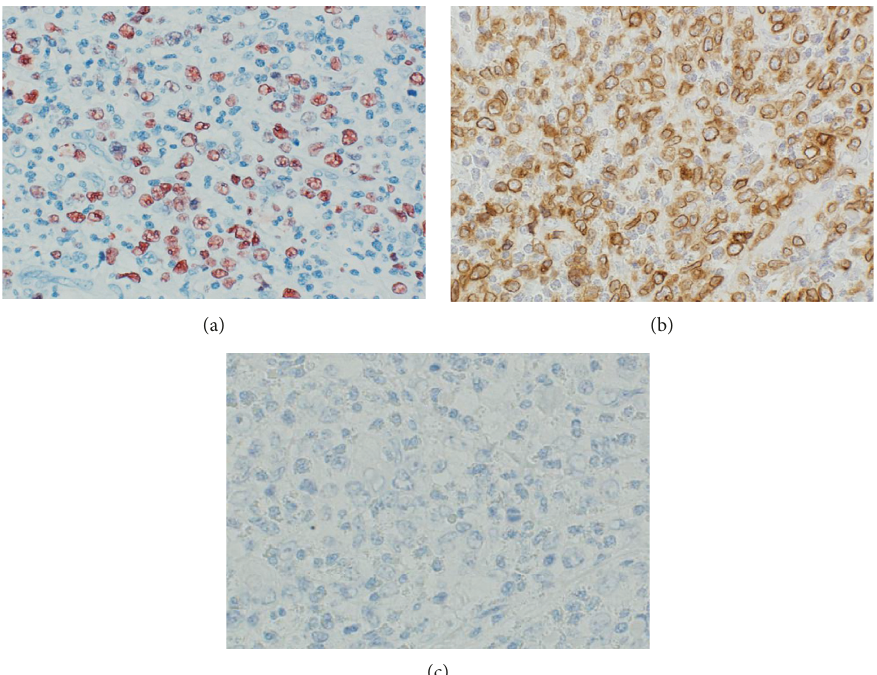
Figure 2: Morphological and immunohistochemical characteristics of the lymphoma ( × 200). (a) In situ hybridization with EBER showing strong Epstein–Barr virus expression by a large atypical lymphocyte. (b) Immunohistochemical staining with CD3 showing strong positive staining. (c) Immunohistochemical staining with CD56 showing negative